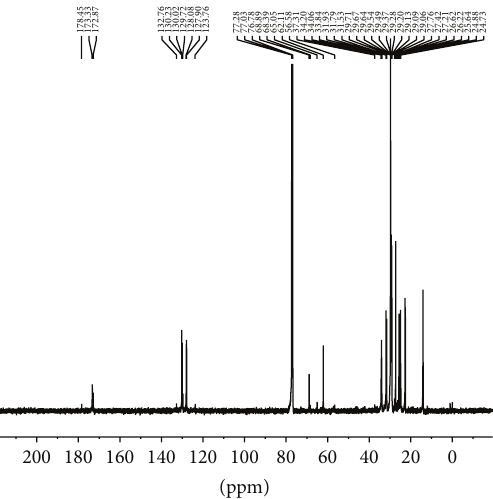
Figure 2: 13 C NMR of C. fistula lipid extracts.